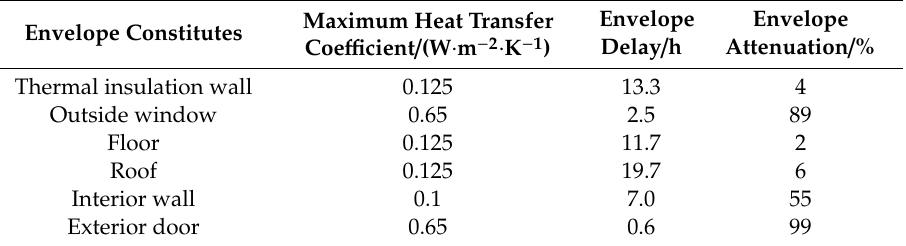
Table 3. Envelope structure